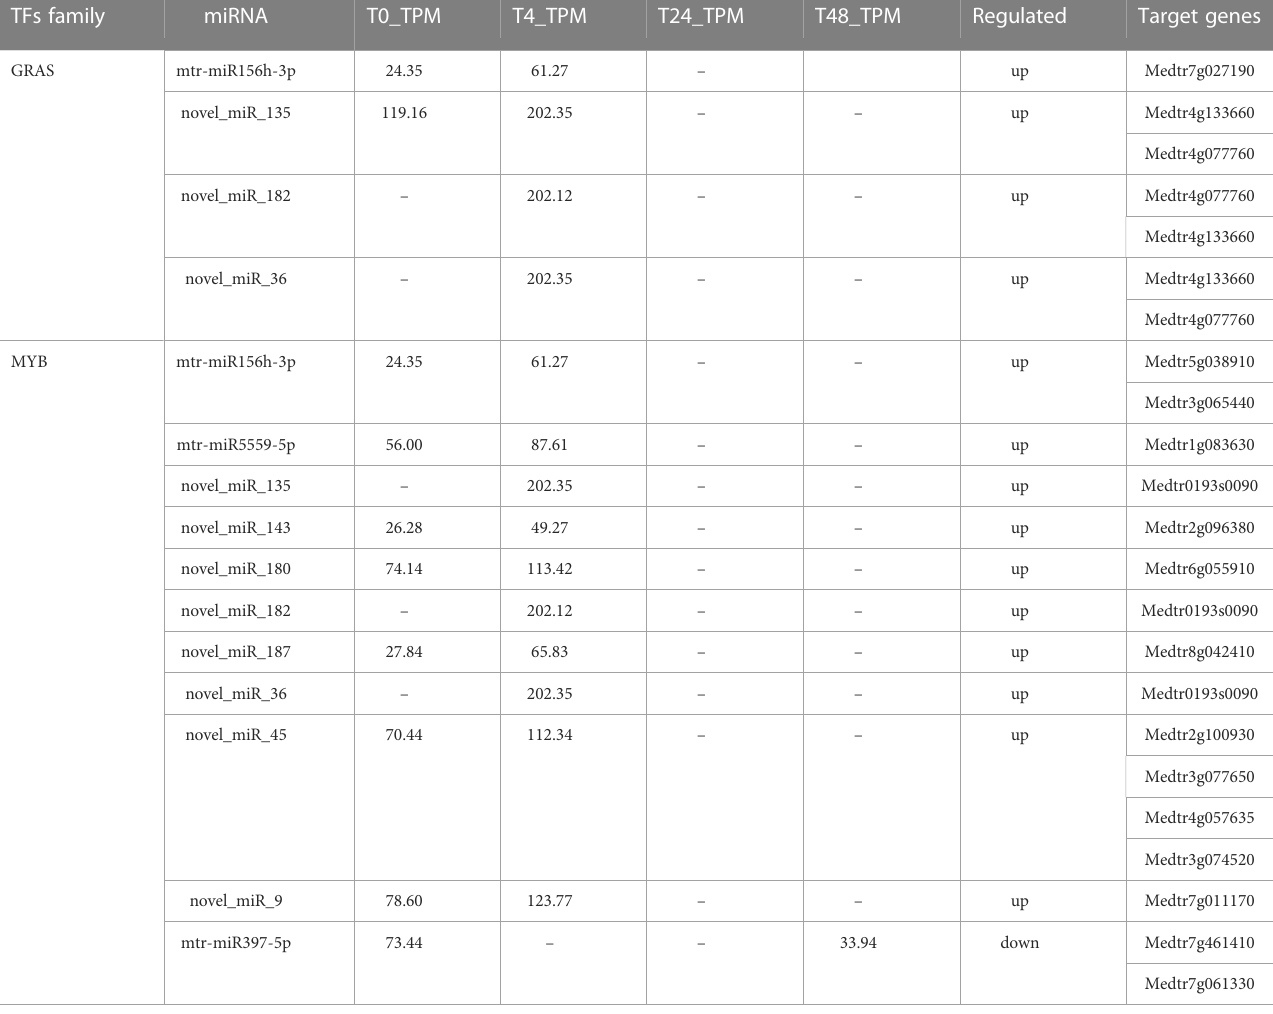
TABLE 1A Information About Special MiRNA.